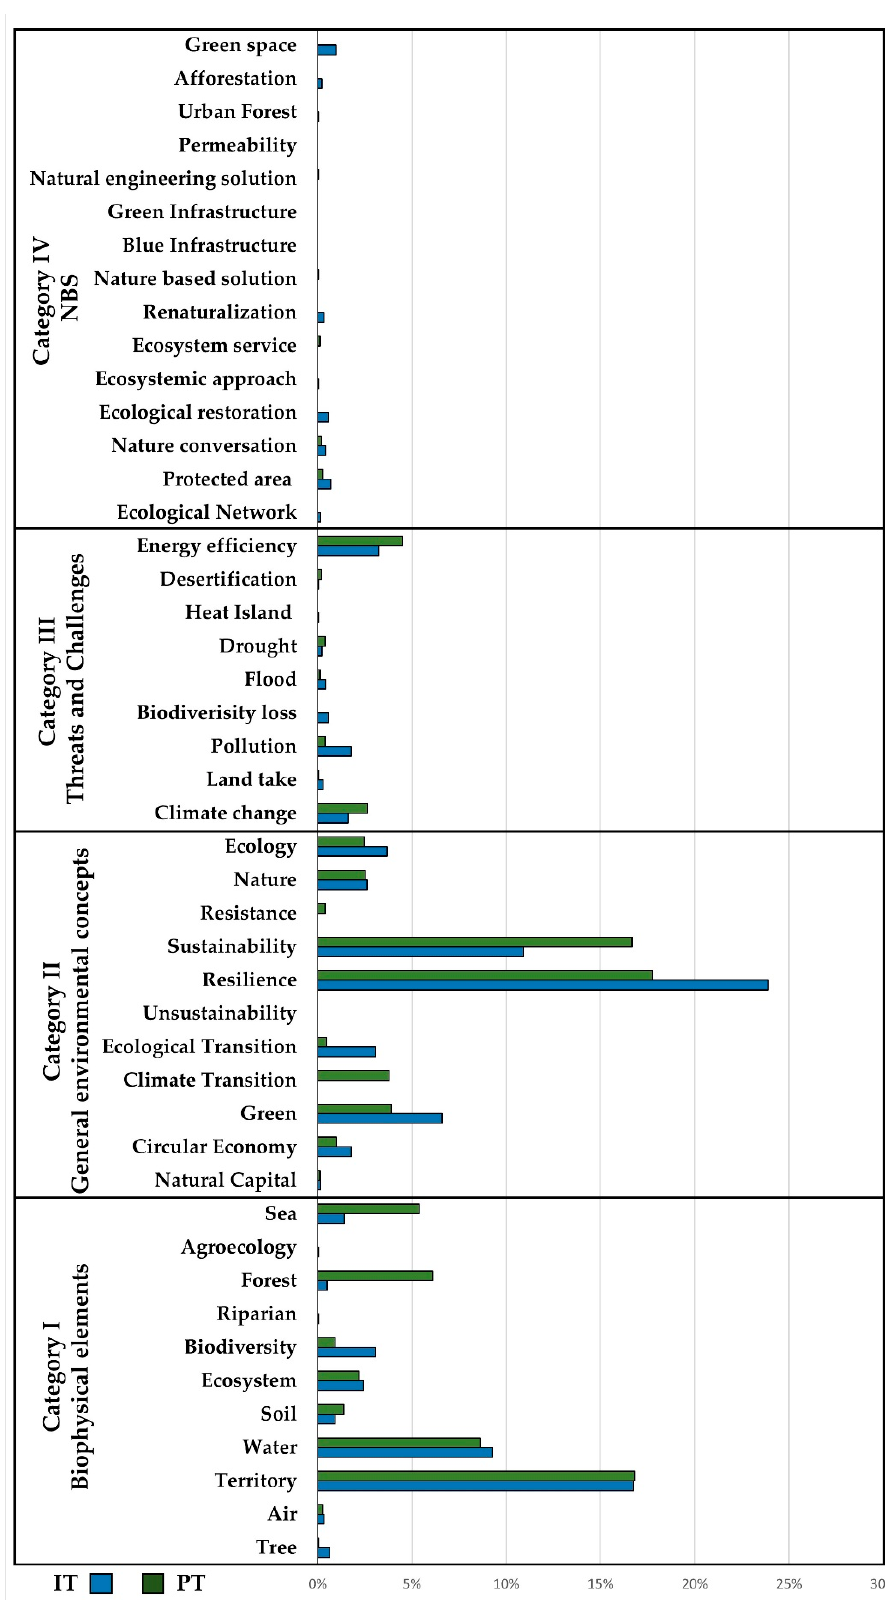
Figure 2. Relative frequency (%) of terms in the text of both national resilience and recovery plans, presented as the percentage of terms by the total amount of coded terms. We reported only the first word of the coded terms, for the complete list please refer to Table 1.